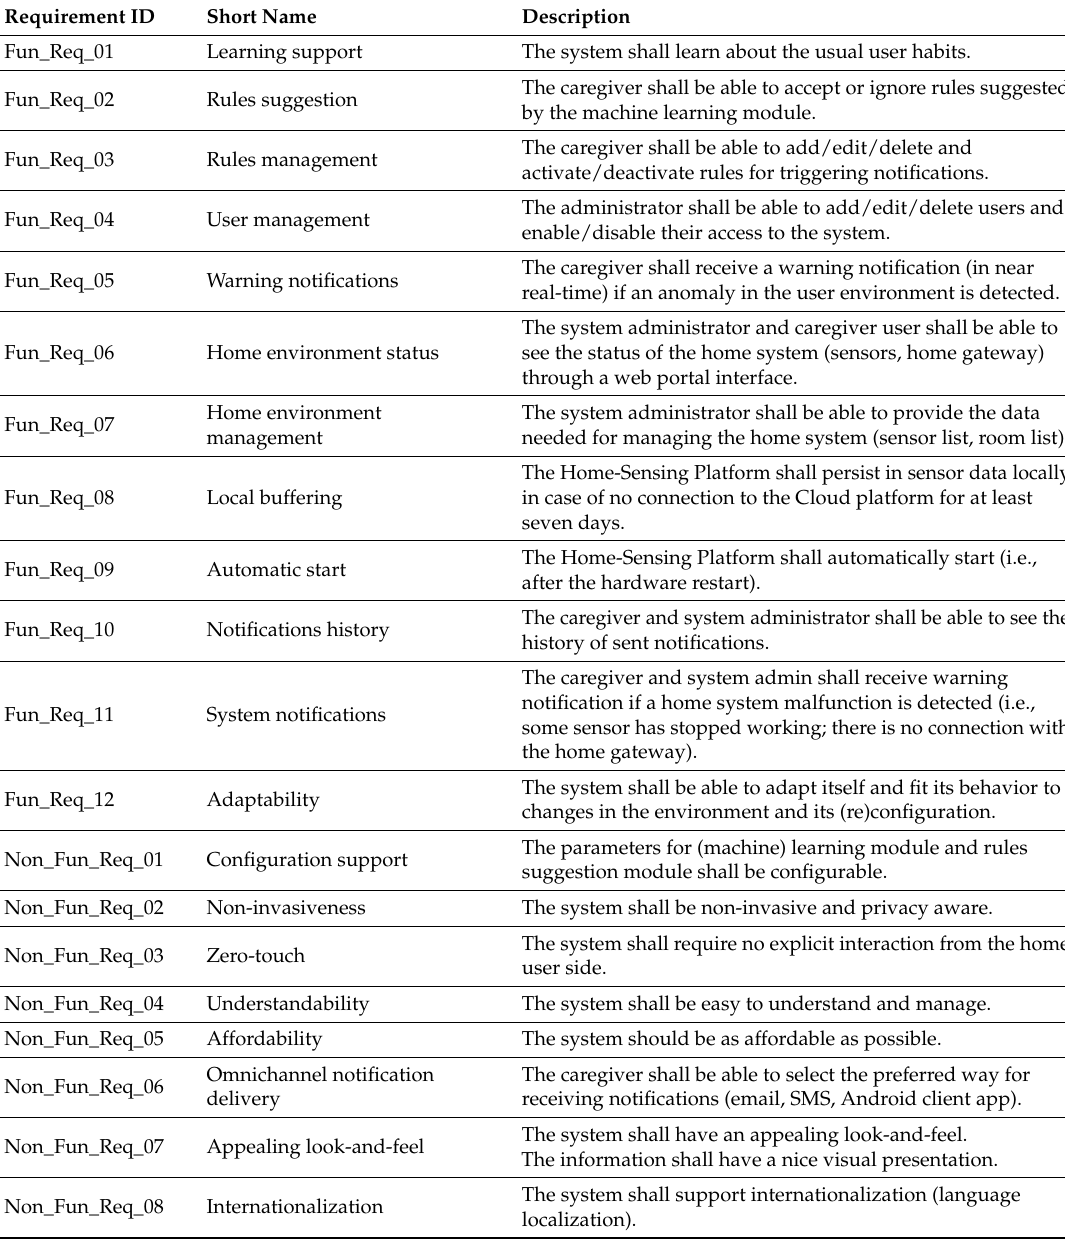
Table 1. Selected mandatory system